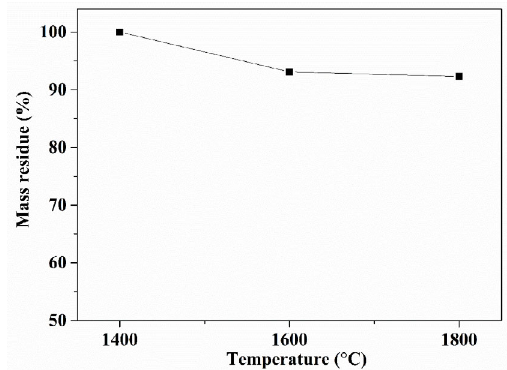
Fig. 9 Mass residue of ABZ-1 derived ZrC–ZrB 2 –SiC ceramic nanocomposites after annealing at high